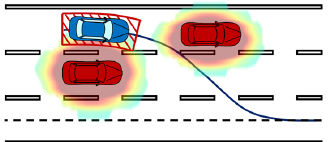
𝑡 (cid:3033) represent the start and end time, respectively, and